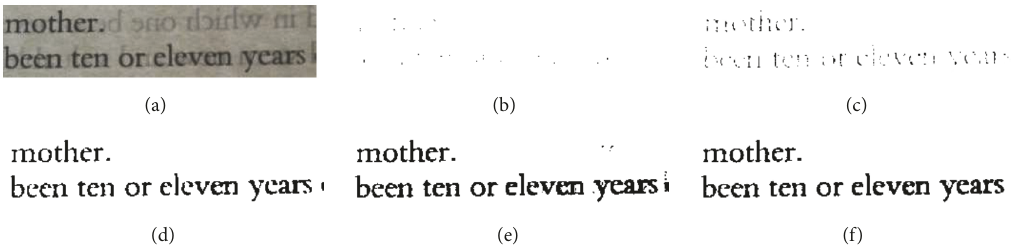
Figure 7: Figures illustrating processed binary images obtained for various values of 𝛼 . (a) The original image, (b) 𝛼 = 1 , (c) 𝛼 = 0.75 , (d) 𝛼 = 0.5 , (e) 𝛼 = 0.25 , (f) ground truth image.